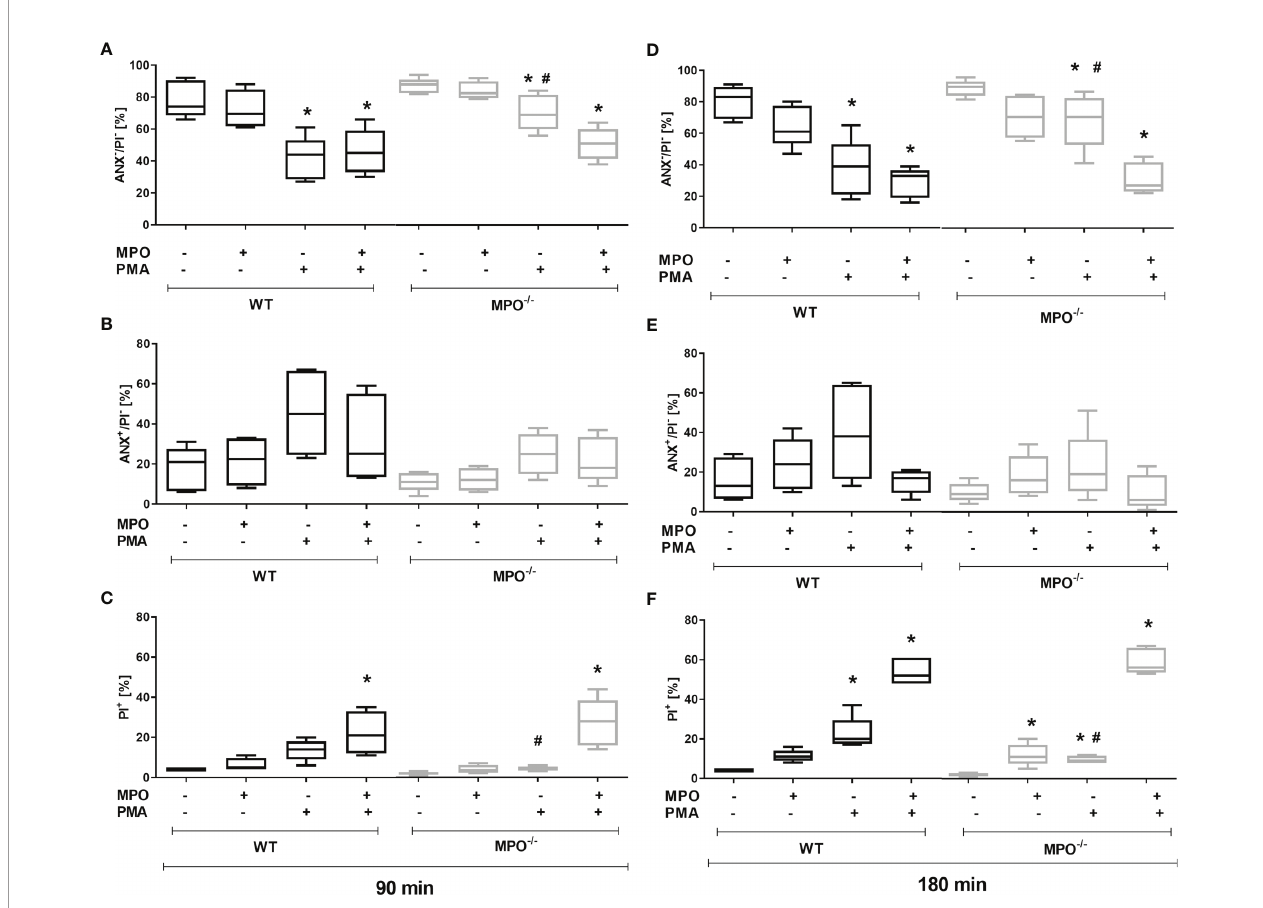
FIGURE 2 | Effect of extracellularly-added MPO on Annexin V + and cell death (PI + ) of PMNs isolated from in fl amed lungs of WT and MPO -/- mice after the induction of oxidative burst by PMA for 90 min (A – C) and 180 min (D – F) . PMNs (3x 10 6 cells/ml) isolated from BALF of WT and MPO -/- mice were pre-treated with/without MPO (20 µg/ml), then stimulated with PMA (80 nM) for 90 and 180 min. Next, cells were evaluated by fl ow cytometry and numbers of viable (ANX - /PI - ), Annexin V + (ANX + /PI - ), and dead cells (PI + , both ANX + /PI + and ANX - /PI + ) were determined. Data are presented as median, 25, and 75 percentiles (the box) and 10 and 90 percentiles (the whiskers), n = 4 – 6. *Shows statistically signi fi cant difference (p < 0.05) compared with untreated control (Ctrl). # shows statistically signi fi cant difference (p < 0.05) between MPO -/- (MPO-KO) and wild-type